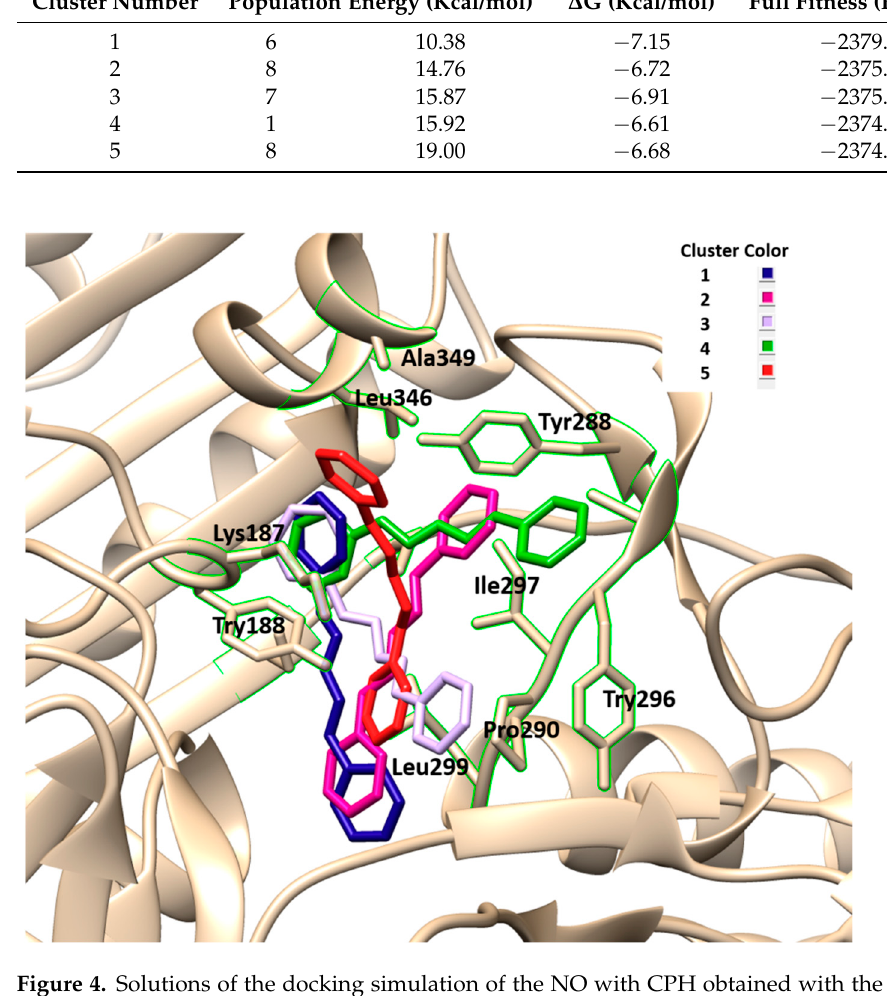
Figure 5. Here, 2D representation of interaction types of CPH with NO enzyme for the first five clusters.